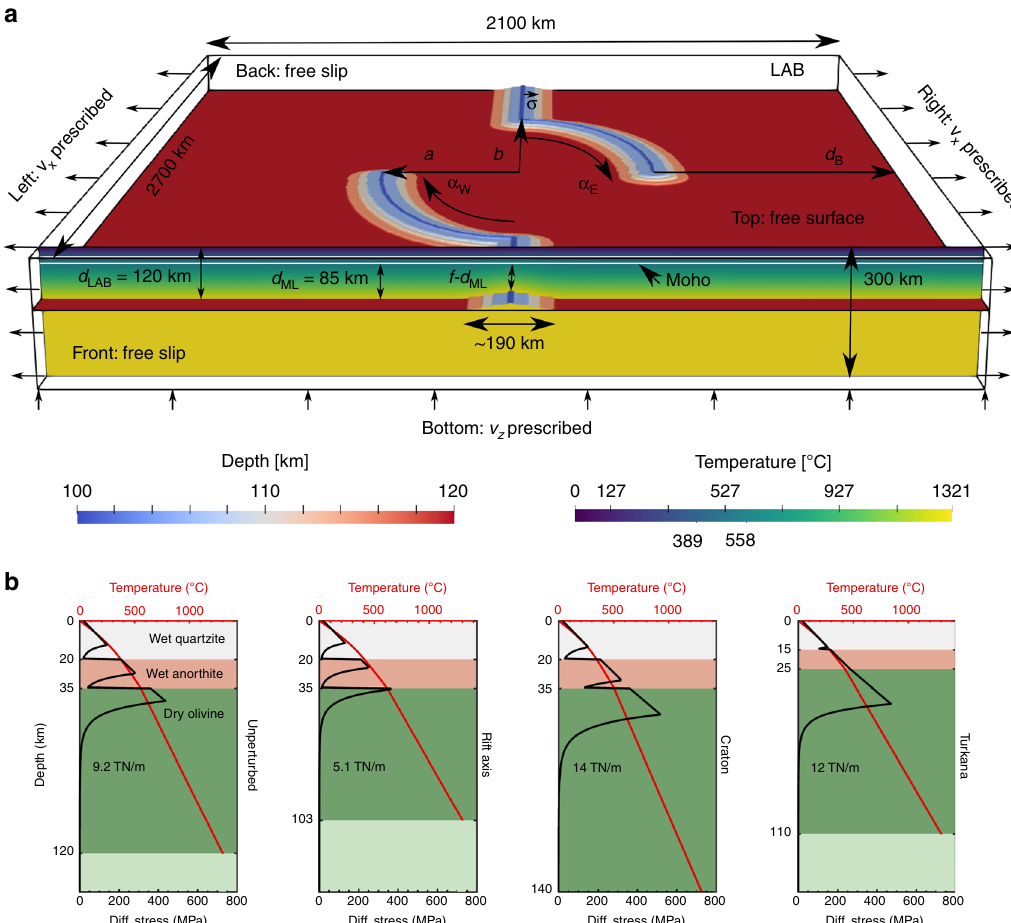
Fig. 2 Generic mobile belt con fi guration model setup and lithospheric strength pro fi les. a A raised Lithosphere – Asthenosphere Boundary (LAB, depth shown in blue-to-red colors) is used to mimic the mobile belts. The perturbed depth of the LAB is constructed using a Gaussian distribution with standard deviation σ = 50 km and amplitude (thinning factor) f = 0.8. The lateral distribution of the perturbation can be divided into straight segments extending from the front and back domain boundaries and the curved segments that follow the outline of an ellipse centered at the midpoint of the domain, and can thus be characterized by the minor and major axes of the ellipse a = 375 km and b = 750 km, and their opening angles α W = 90° and α E = 90°. The minimum distance of the curved segments to the east and west boundaries is d B = 675 km. Prescribed velocities are v x ¼ 1 case. The vertical slice shows the initial temperature fi eld (which includes the same perturbation) together with the laterally homogeneous crustal layers outlined in white. Temperatures at the upper/lower crust and Moho interfaces are indicated below the temperature scale bar. Top and bottom temperatures are fi xed at 273 and 1594 K, respectively. b Lithospheric strength and temperature pro fi les at representative locations for a lithostatic pressure and background strain rate determined by the velocity boundary conditions of ~ 8 × 10 − 17 s − 1